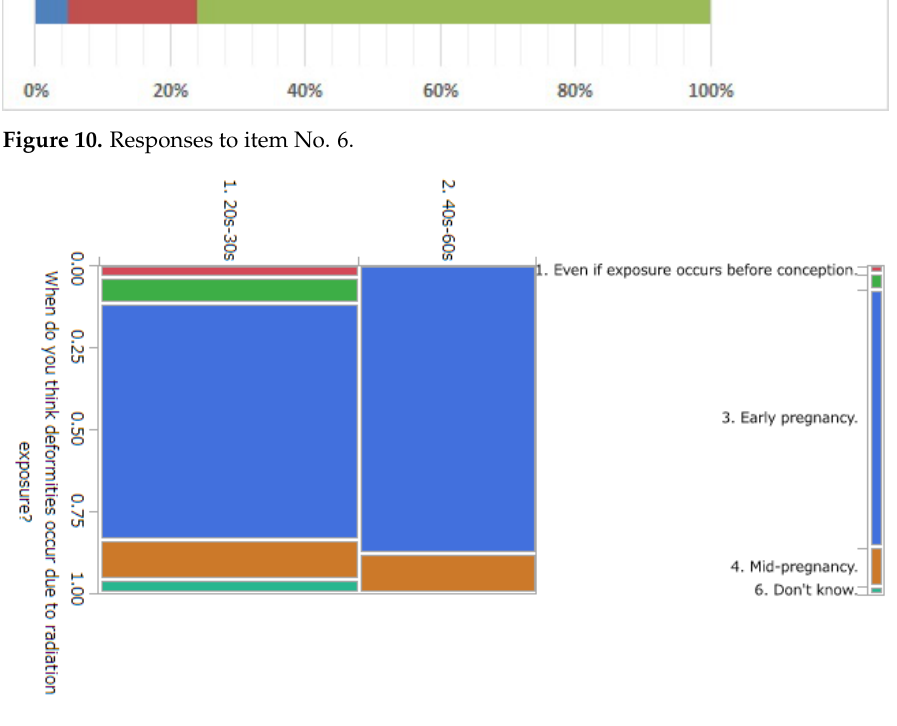
Figure 11. Responses to item No. 6 by Age